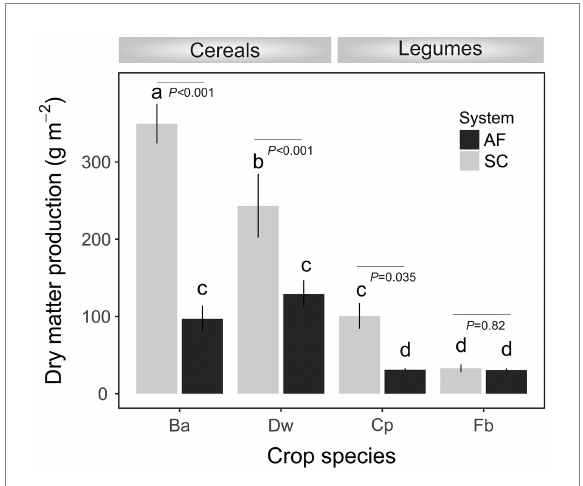
FIGURE 2 Dry matter production at the flowering stage of crops (Ba, barley; Dw, durum wheat; Cp, chickpea; Fb, Faba bean) in agroforestry system (AF) and full sun cropping (SC) systems. Bars indicate the mean biomass ± SE . Letters show significant differences from the ANOVA and post-hoc Tukey